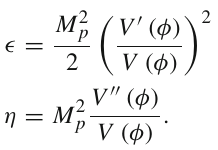
Table 2 The 95% limits on the slow-roll parameters and the derived parameters from the data combinations of CMB + BAO and